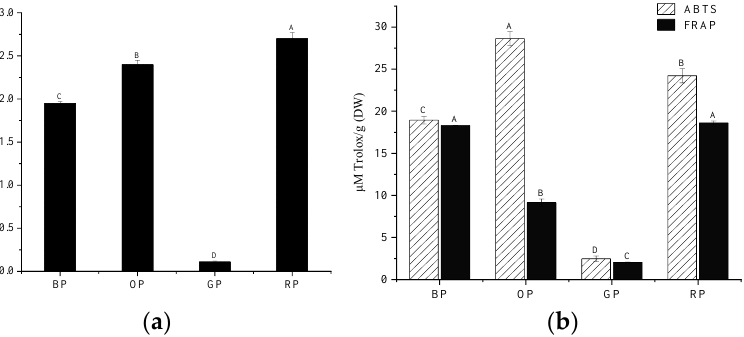
Figure 4. ( a ) Total phenolics in spices; ( b ) antioxidative abilities of spices. Columns with different letters (A –D) indicate significant difference between samples (α = 0.05 level). OP: Onion powder; RP: Red pepper powder; BP: Black pepper; GP: Garlic powder; 2 N.D. means not detected.